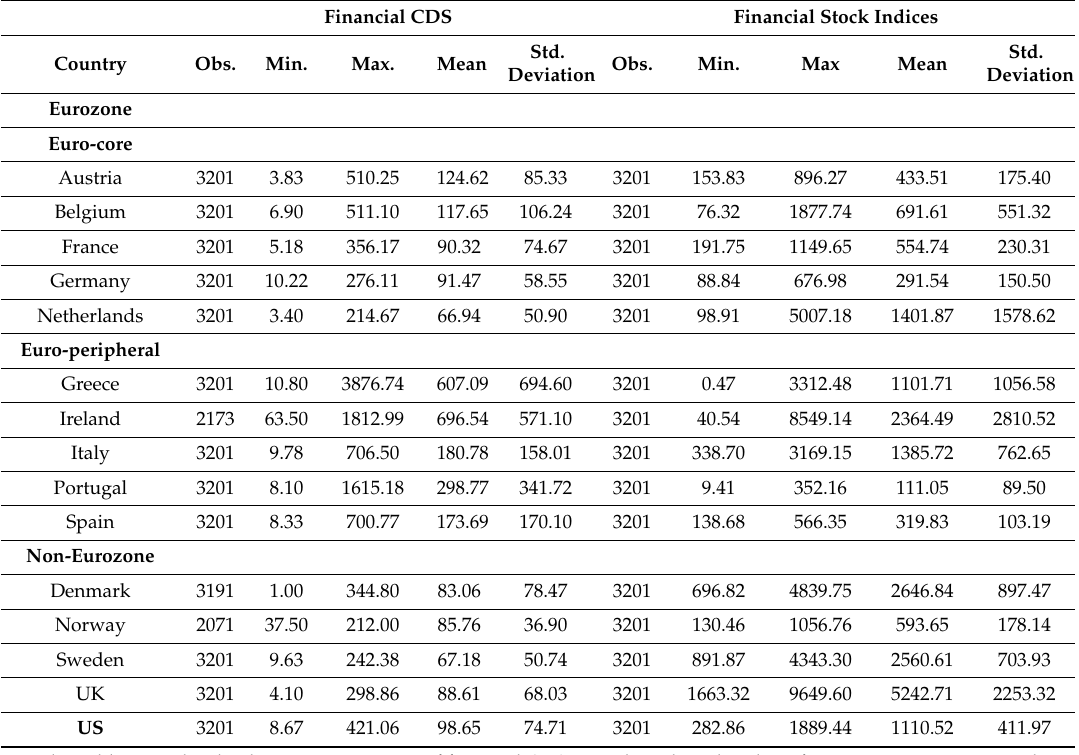
Table 5. Main descriptive statistics of daily financial stock indices and bank CDS